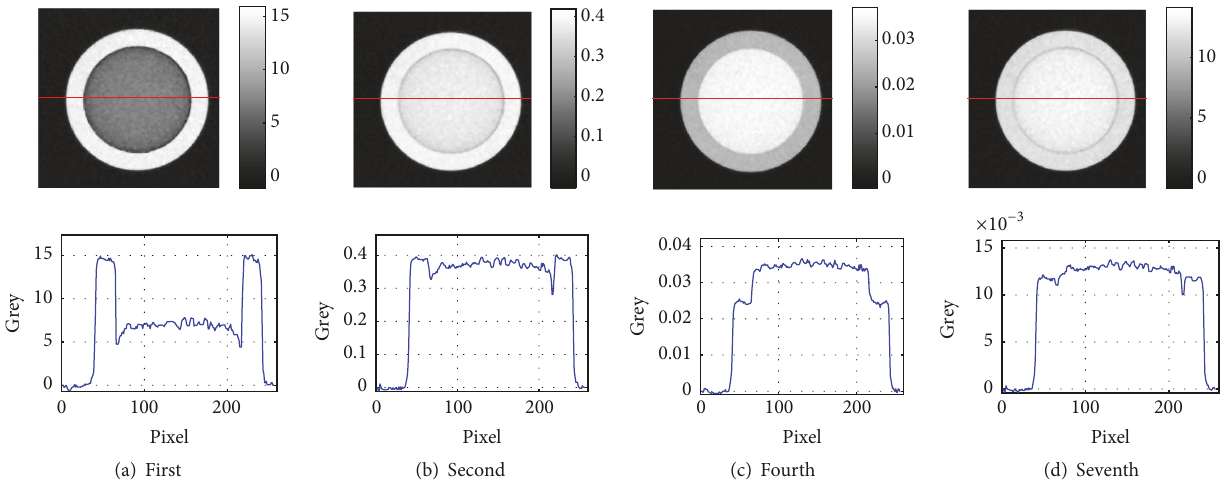
Figure 4: Four representational reconstructed images obtained by the method of this paper.